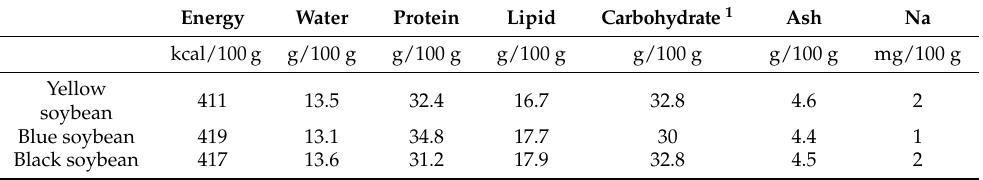
Table 1. General ingredients of three kinds of